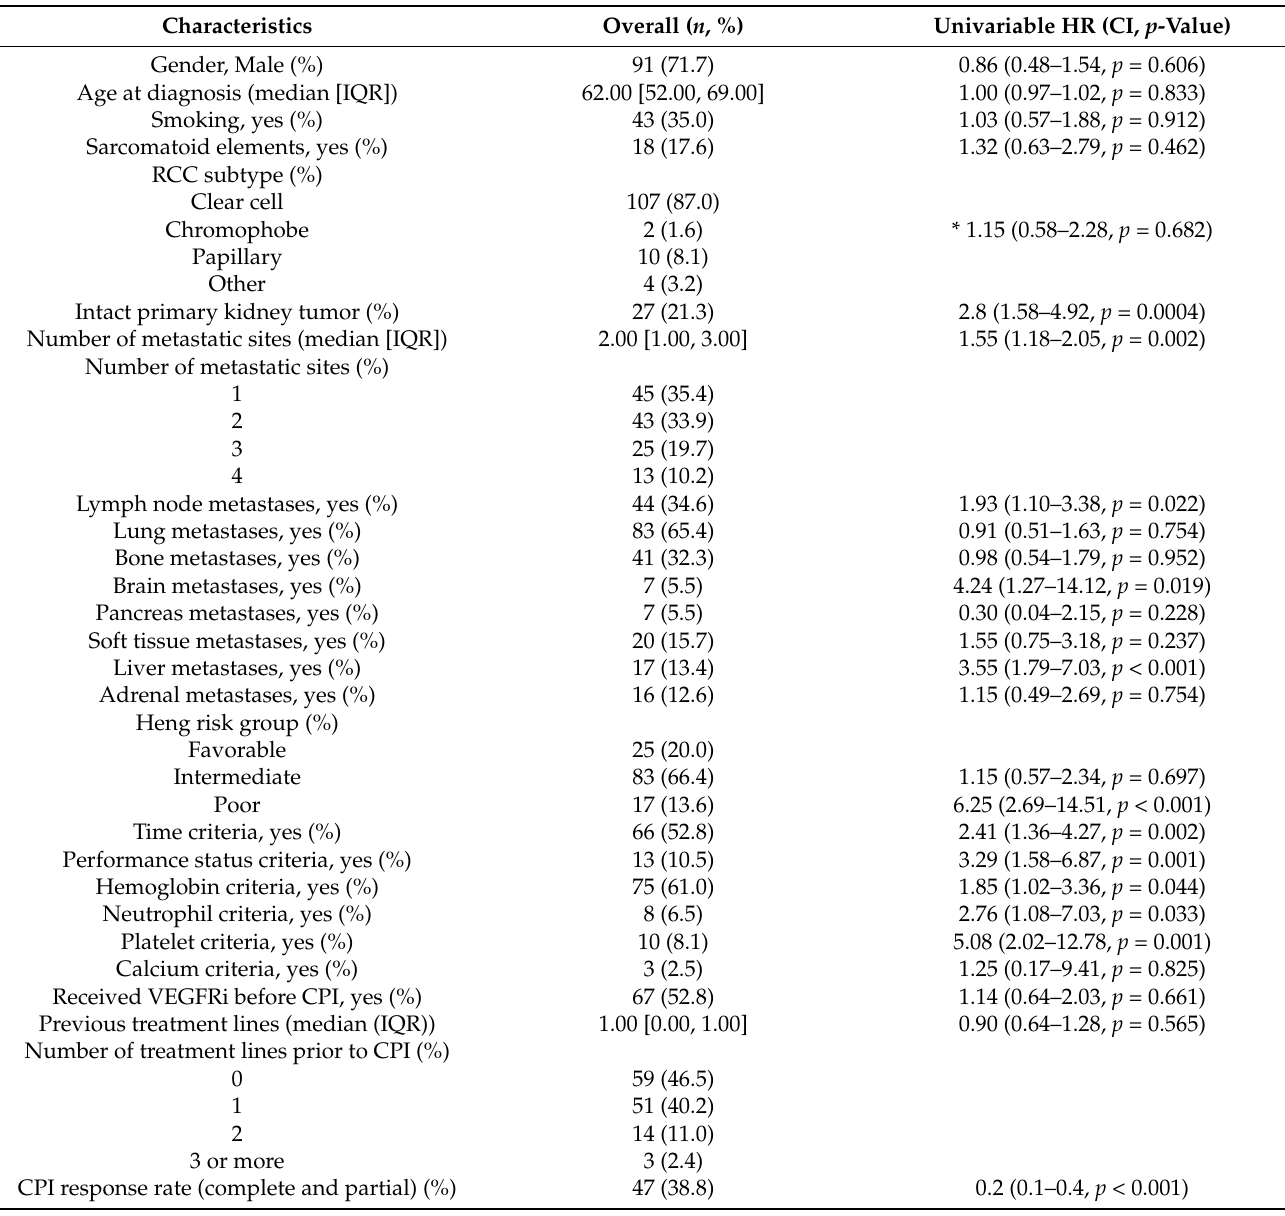
Table 1. Patient characteristics of study population and univariable hazard